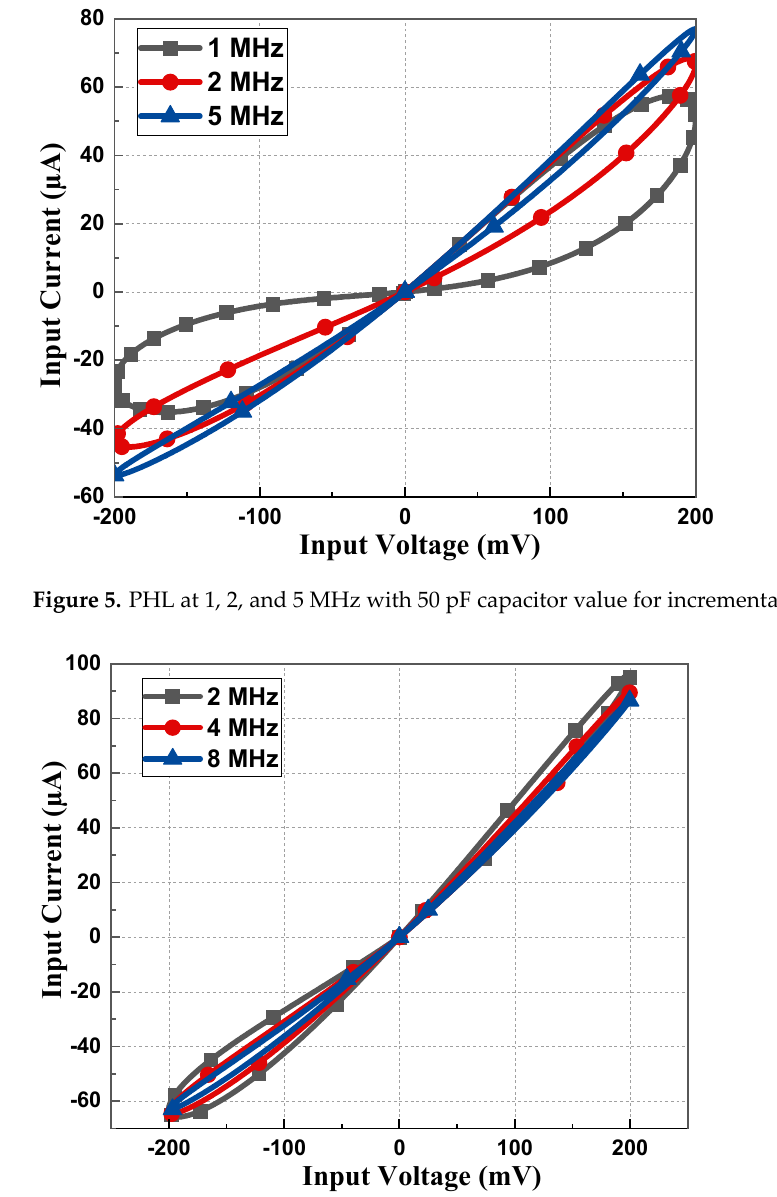
Figure 6. PHL at 2, 4, and 8 MHz with 50 pF capacitor value for decremental configuration.